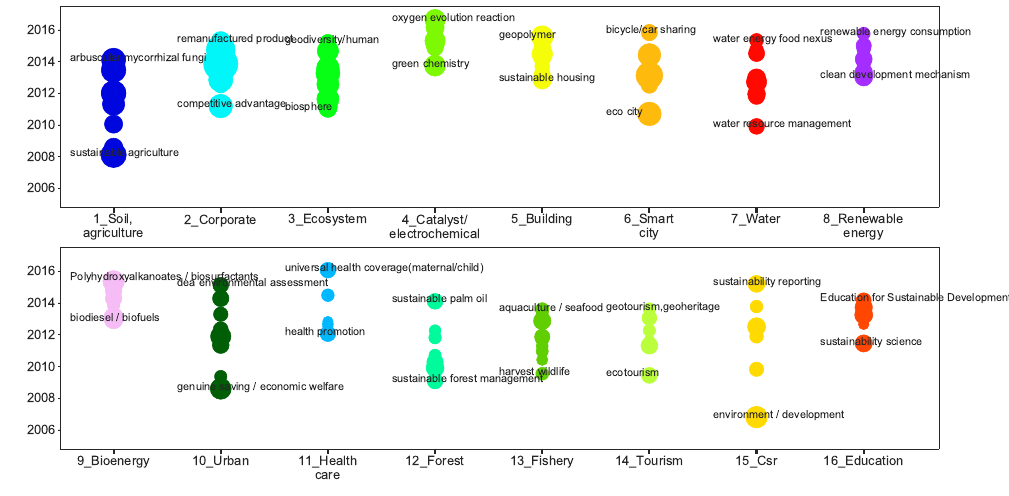
Figure 3. Subclusters of each cluster of sustainability science. The vertical axis represents the average publishing year of papers belonging to each